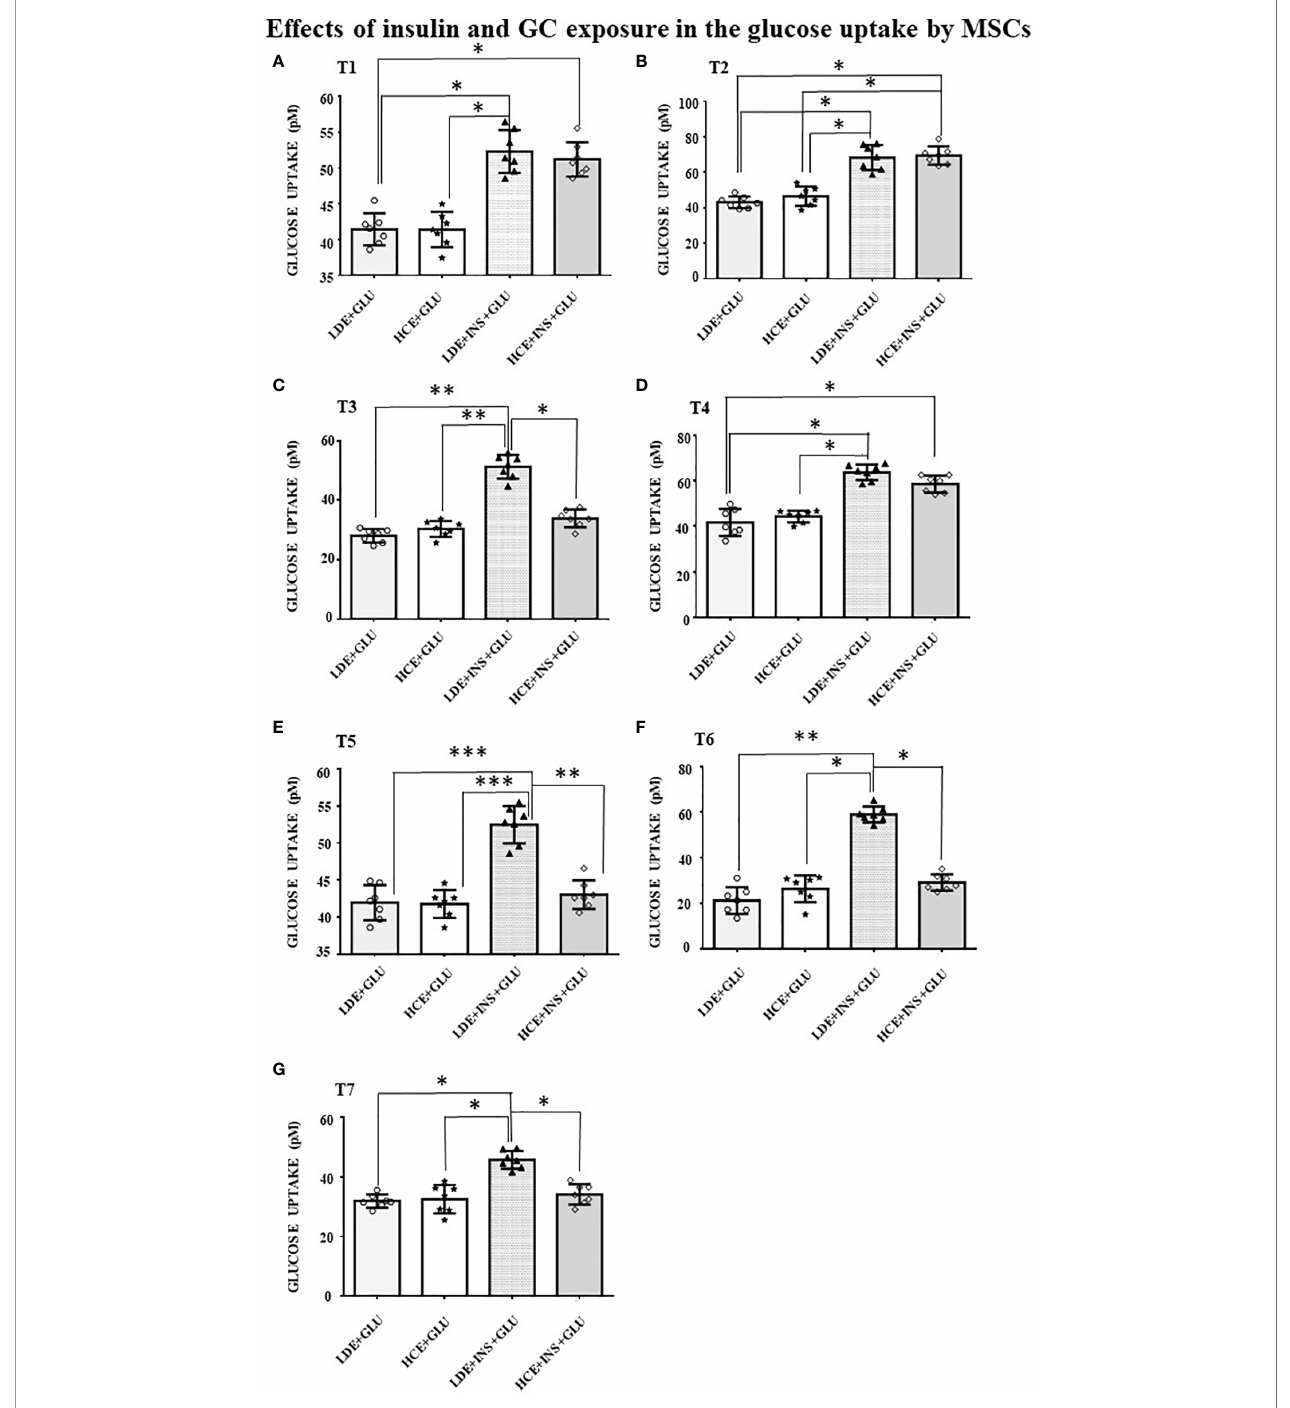
FIGURE 6 | Glucose uptake in MSCs undergoing a LDE or a HCE to GCs. The bars represent the glucose uptake expressed in pM at T1 (9:50 a.m. fi rst day, A ), T2 (1:50 p.m. fi rst day, B ), T3 (5:50 p.m. fi rst day, C ), T4 (9:50 a.m. second day, D ), T5 (1:50 p.m. second day, E ), T6 (5:50 p.m. second day, F ) and T7(1:50 p.m. third day, G ) in MSCs undergoing a LDE or a HCE to GCs and stimulated or not with insulin. One-way ANOVA; *p < 0.05,**p < 0,01,***p < 0,001. LDE+GLU: LDE (Lower and Decreasing Exposure) cells treated with glucose; HCE+GLU: HCE (higher and Constant Exposure) cells treated with glucose; LDE+INS+GLU: LDE cells stimulated with insulin before glucose exposure; HCE+INS+GLU: HCE cells stimulated with insulin before glucose exposure. Data are expressed as mean ± SD of the readings for MSCs derived from each single patient over three independent